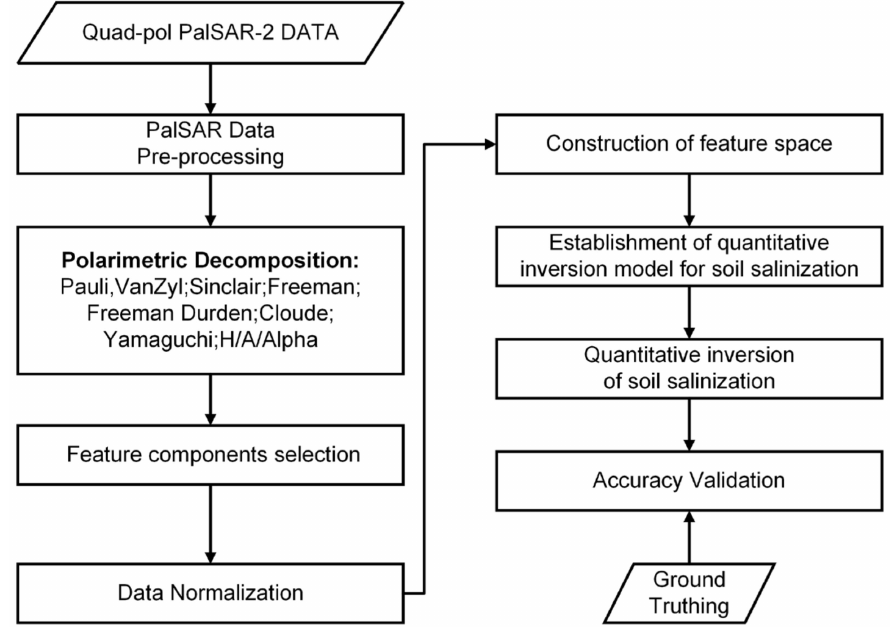
Figure 4. The overall workflow of the